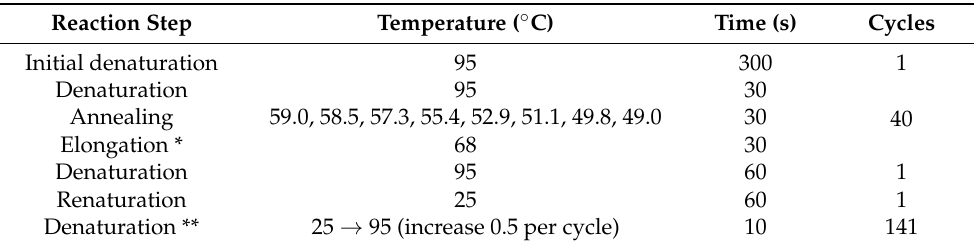
Cycling programs of the gradient-PCR and melt curve analysis for the prtP - qPCR